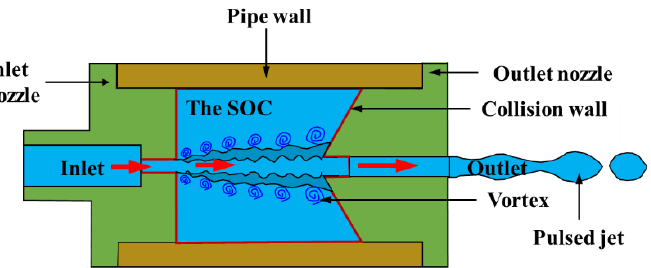
Figure 1. Schematic diagram of the self-excited oscillation pulsed jet nozzle.